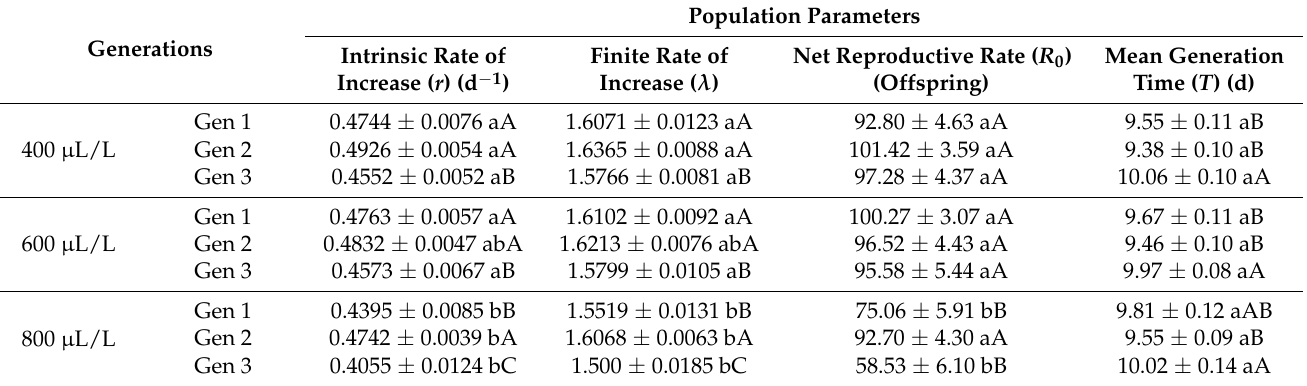
Figure 2. Age-stage-specific reproductive value ( v xj ) of three successive generations of L. erysimi under three CO 2 treatments. Table 2. Population parameters of successive three generations of L. erysimi under three CO 2 treat- ments (mean ±